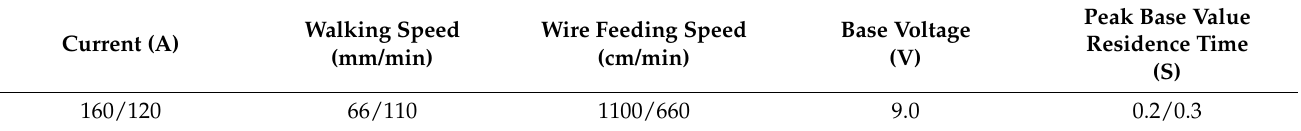
Table 3. Test board welding and filling parameters.